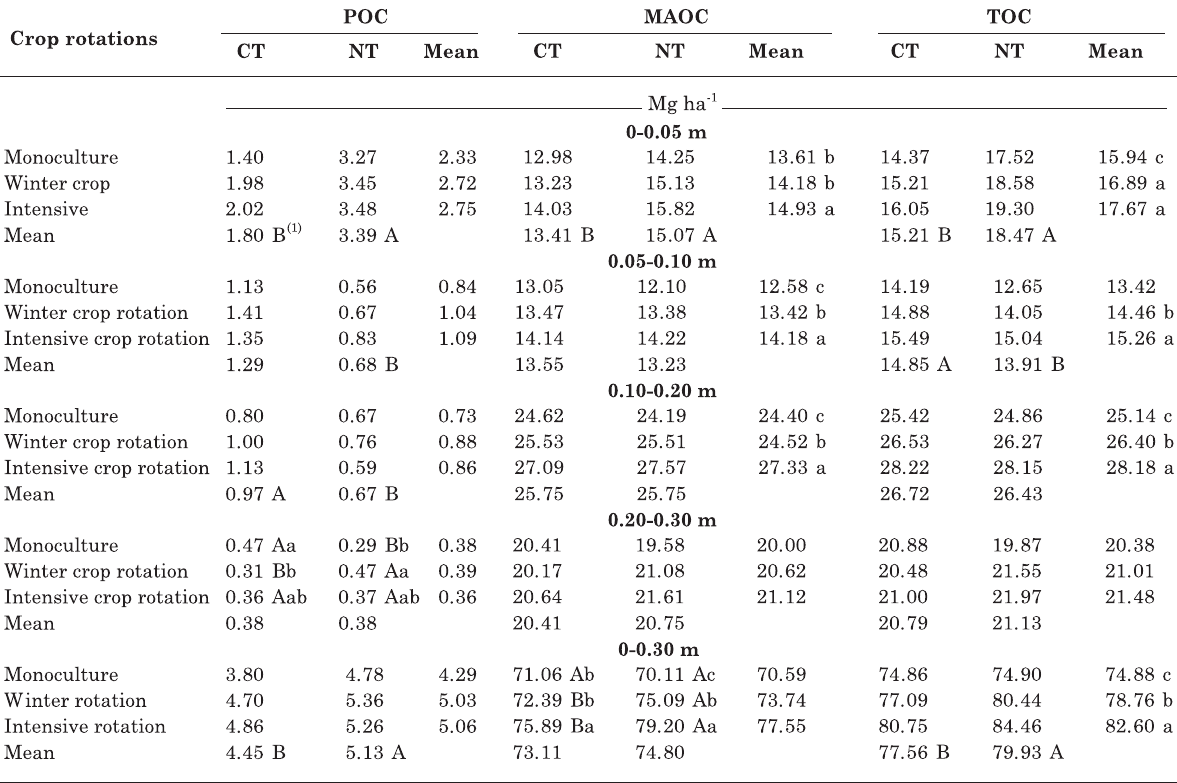
Table 3. Particulate organic carbon (POC), mineral-associated organic carbon (MAOC) and total (TOC) organic carbon pools of a subtropical Oxisol under conventional tillage (CT) and no tillage systems (NT) under three cropping systems (R0=wheat/soybean, R1=wheat/soybean/black